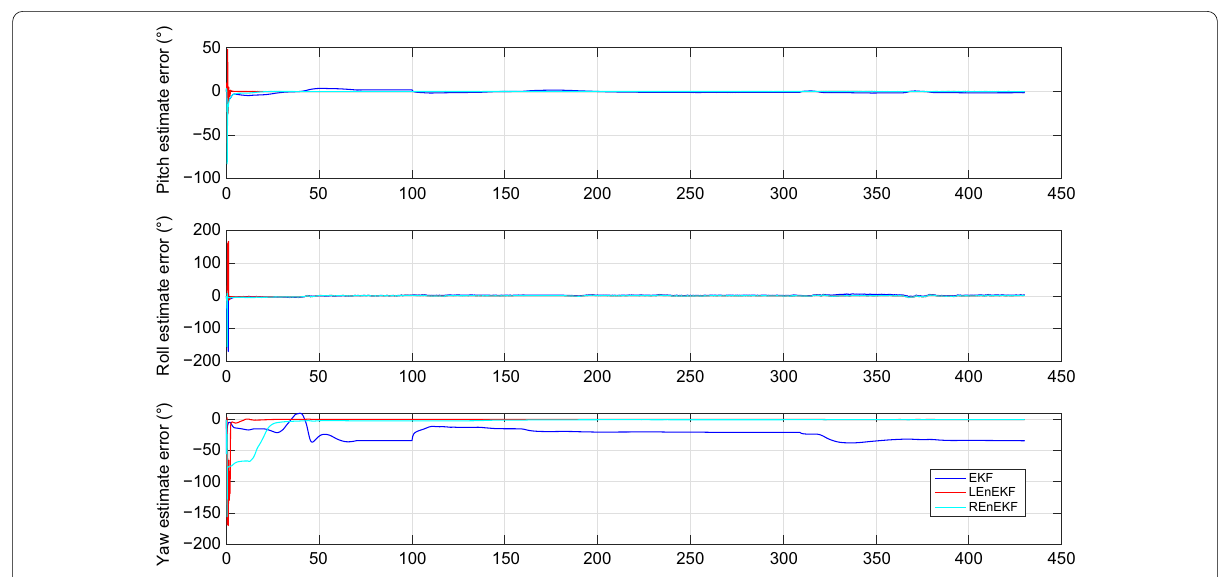
Fig. 3 Roll, pitch, and, yaw angle estimated results in field experiment with large misalignment angle